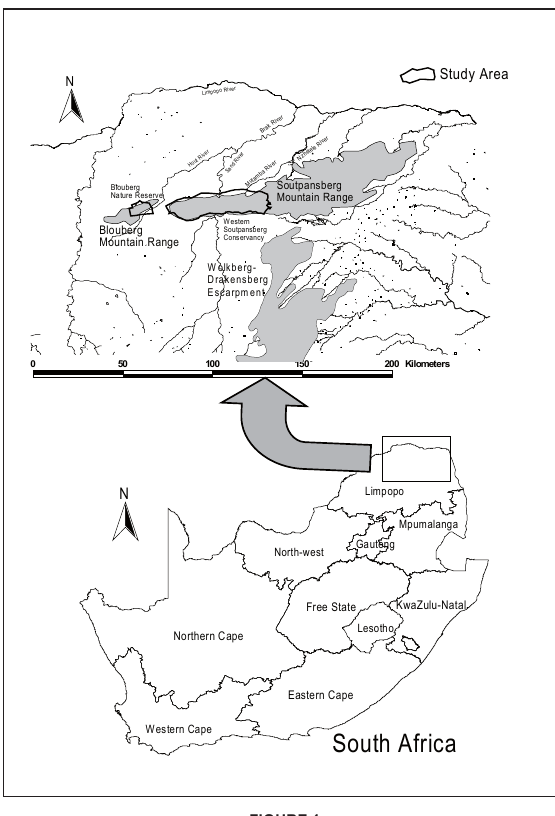
Figure 1 The location of the Blouberg Nature Reserve and Western Soutpansberg Conservancy within South Africa.